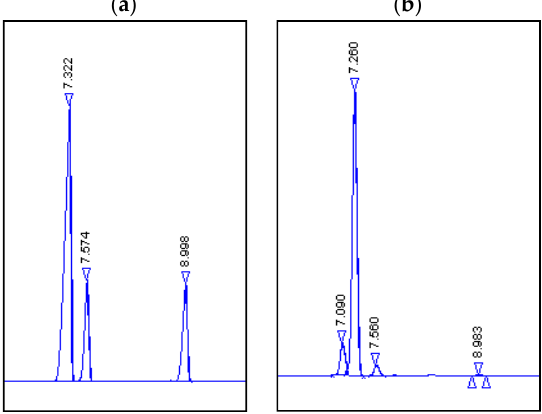
Figure 1. Chromatograms. ( a ) Products obtained by biotransformation using potato: R f = 7.090, (1 R ,2 R ,4 R )-dihydrocarveol ( 4 ); R f = 7.260, (1 R , 4 R )-(+)-dihydrocarvone ( 2 ); R f = 7.560, (1 S , 4 R )-(+)-dihydrocarvone ( 3 ); unreacted substrate R f = 8.983, (4 R )-(–)-carvone ( 1 ). ( b ) Standards: R f = 7.322, (1 R , 4 R )-(+)-dihydrocarvone ( 2 ); R f = 7.574 (1 S , 4 R )-(+)-dihydrocarvone ( 3 ); R f = 8.998, (4 R )-(–)-carvone ( 1